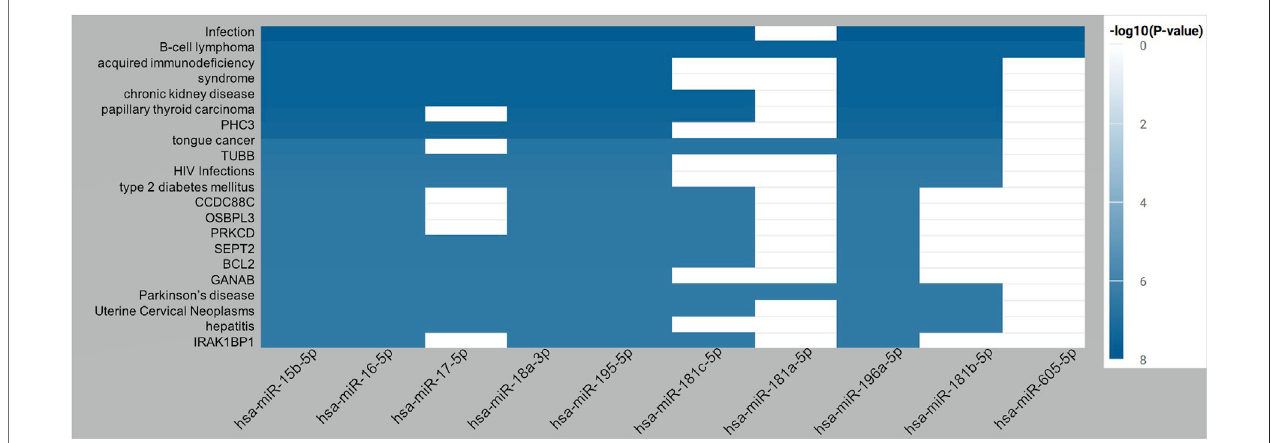
FIGURE 4 | Top twenty enriched terms for the top 10 predicted MS-related